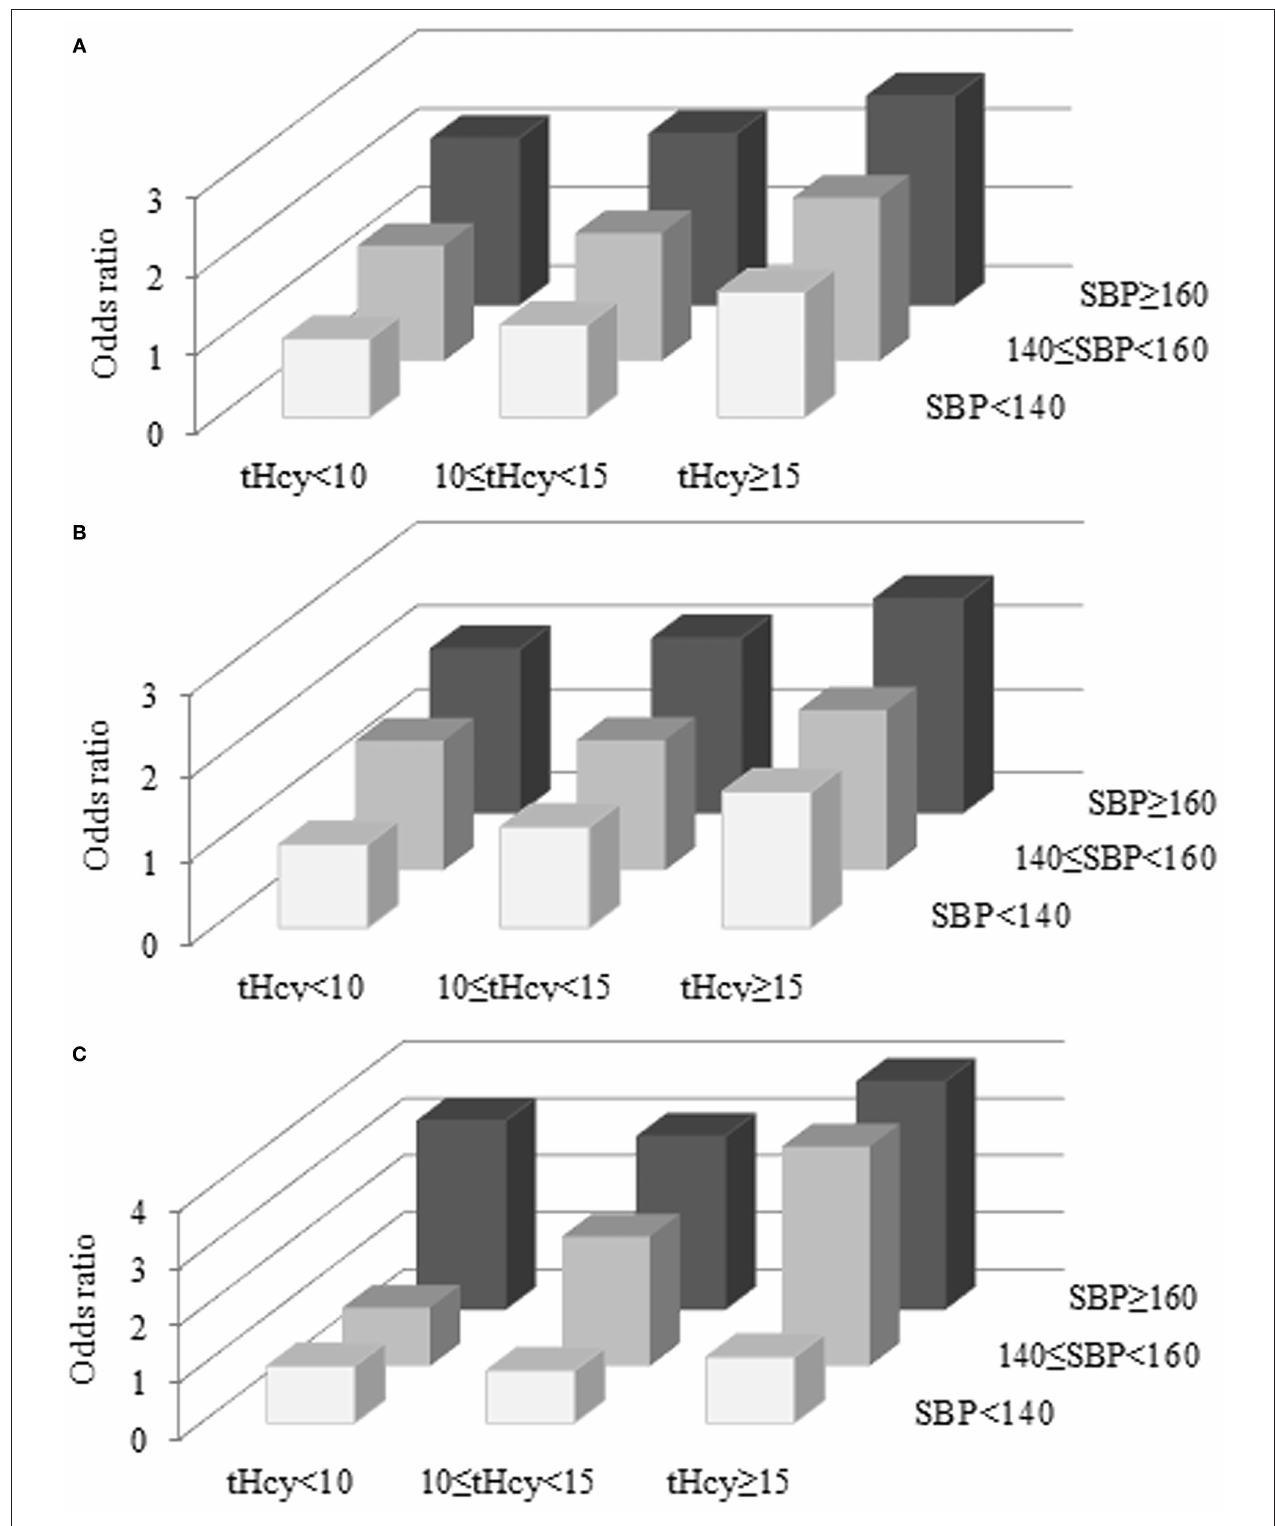
FIGURE 2 | Combined effects of SBP and tHcy on the risk of first stroke (A) , ischemic stroke (B) , and hemorrhagic stroke (C) . tHcy, µ mol/L; SBP, mmHg.